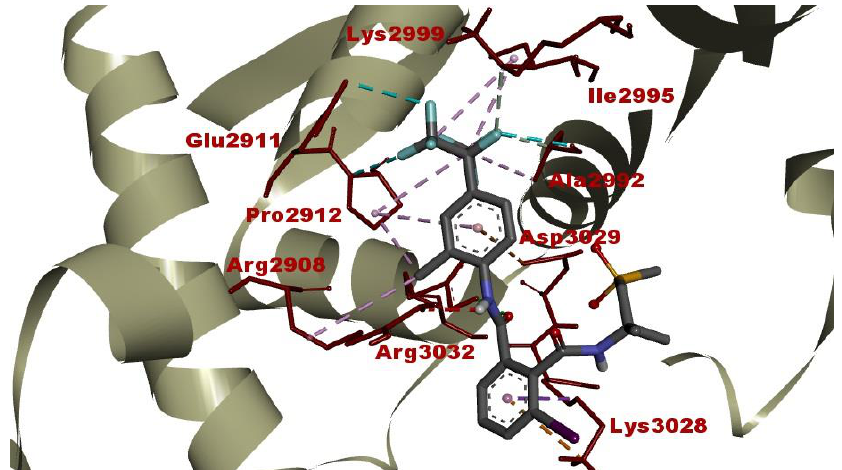
Figure 10. Post-docking top-ranked conformation of flubendiamide in complex with DBM RyR Repeat34 domain. The green and light grey dashed lines represent hydrogen bonds, whereas the purple and light cyan dashed lines represent hydrophobic contacts and halogen (fluorine) interactions, respectively.